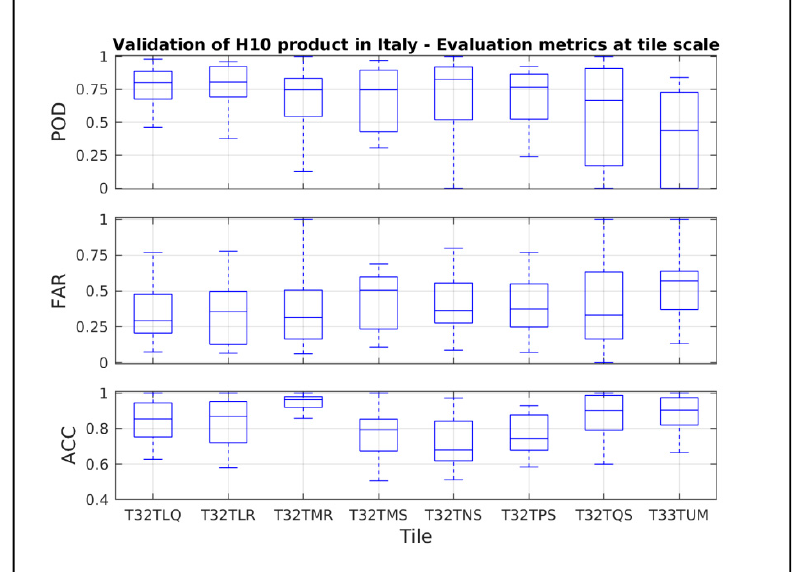
Figure 13. Evaluation metrics at tile scale in Italy.